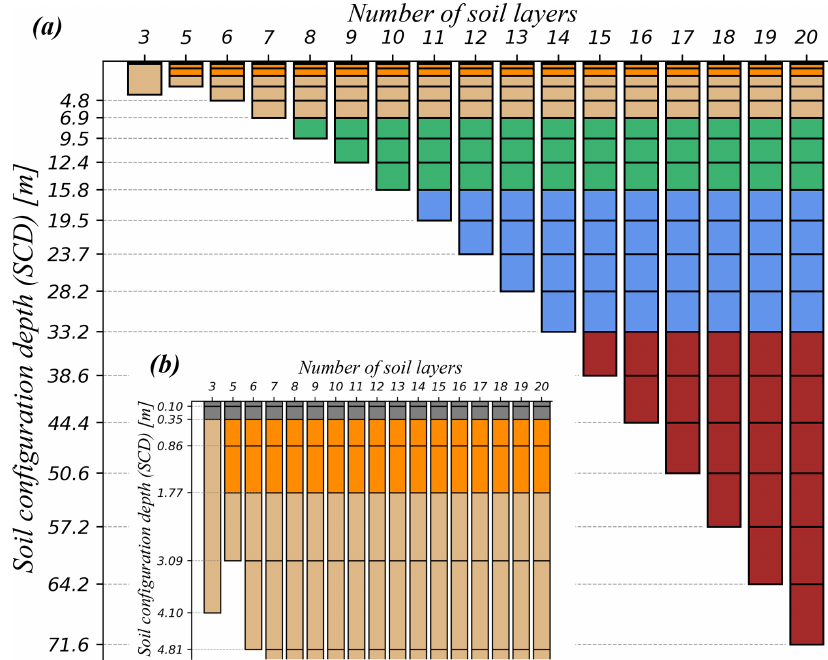
Figure 5. The variable soil configuration profiles defined for the 1-D model: number of soil layers, depth of each layer, and total depth. Each colour represents a group of layers that are assigned the same parameter values. Panel (a) shows all the configurations and panel (b) shows a zoom-in window of the previous panel for the first few layers. The first soil configuration (three layers) represents the standard CLASS soil model configuration.